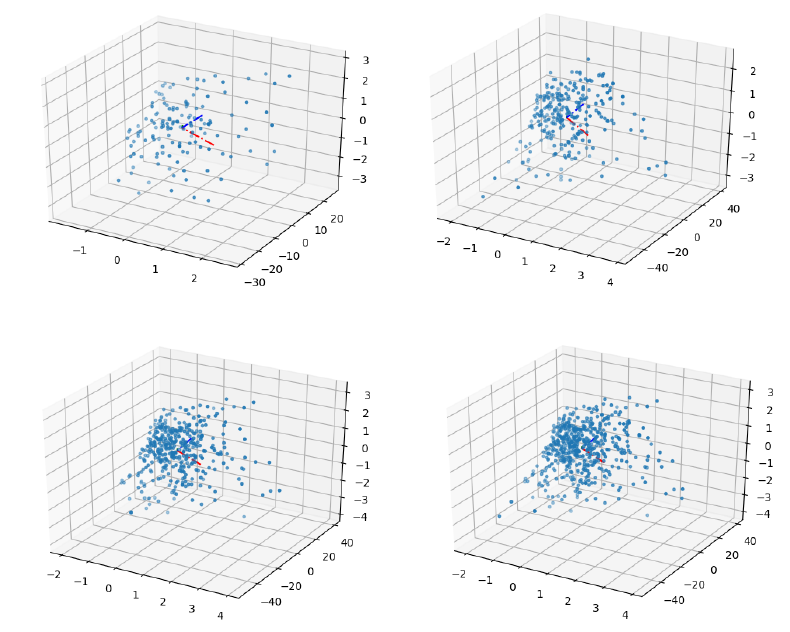
Figure 15. Global view of objective space for different sample density and their eigenvectors.